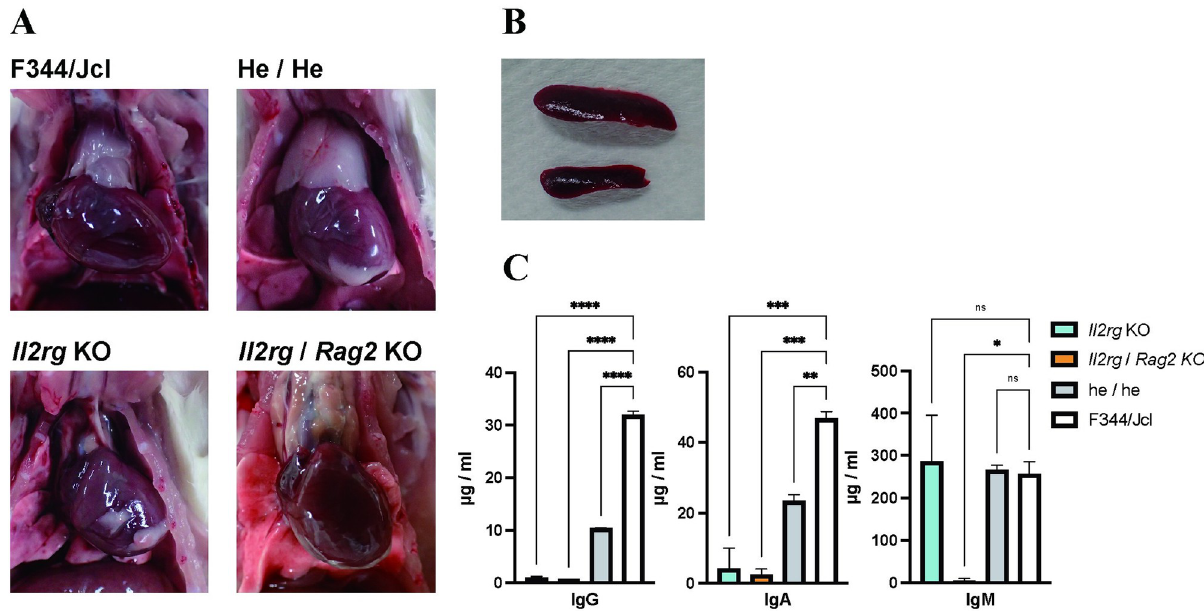
Fig 2. Knockout of Il2rg and Rag2 caused deficient development of lymphocytes. (A) Images of thymus specimens from F344/Jcl wild-type, double heterozygote, Il2rg -single-knockout (sKO), and Il2rg / Rag2 -double-knockout (dKO) rats. (B) Images of spleen specimens from 4-week-old double heterozygote (top) and Il2rg -sKO (bottom) rats. (C) Serum IgM, IgG, and IgA levels in F344/Jcl wild-type, double heterozygote, Il2rg -sKO, and Il2rg / Rag2 -dKO rats, measured by ELISA. Multiple comparisons of each group (sKO, dKO, or he/he; double heterozygote) versus F344/Jcl were conducted using Dunnett’s test. Asterisks or “ns” represent adjusted p -values: ns, 0.1234; � , 0.0332; �� , 0.0021; ��� , < 0.0002; ���� , < 0.0001.